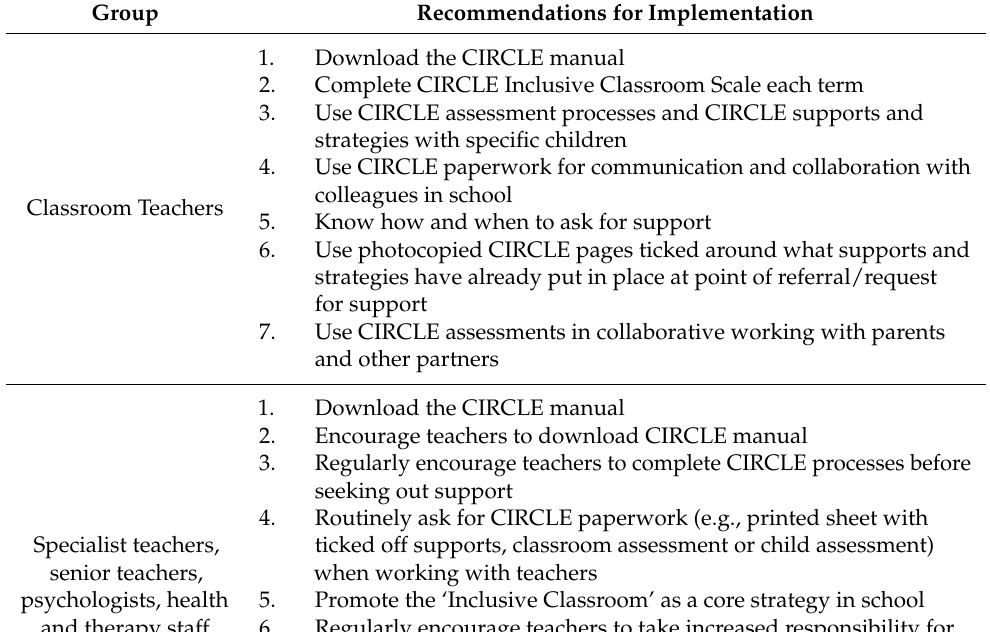
Table 2. Recommendations for implementation of CIRCLE across various levels of